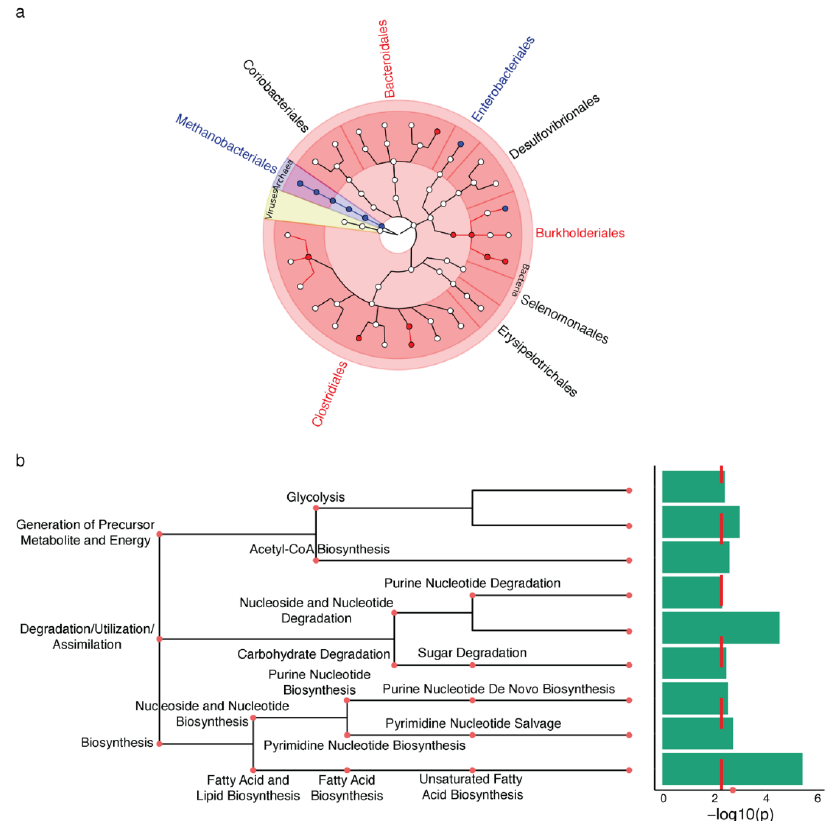
Figure 1. The Parkinson’s disease (PD) appendix exhibits shifts in the active microbiota that affect lipid metabolism. Meta- transcriptomic analysis was used to determine the changes in the functional microbiota in the PD appendix ( n = 12 PD, 16 controls). ( a ) Microbiota changes in the PD appendix. Metatranscriptome data were analyzed by MetaPhlAn2 and a zero- inflated Gaussian mixture model in metagenomeSeq, adjusting for age, sex, RNA integrity number (RIN), and post-mor- tem interval. Results are displayed using GraPhlAn, showing the taxonomic tree with the kingdom in the center, and branching outwards to phylum, class, order, family, and genus. Microbial taxa highlighted in red are increased in PD, and blue are decreased in PD ( q < 0.05, metagenomeSeq). ( b ) Microbiota metabolic processes are altered in the PD appendix. Top microbial pathways are altered in PD as identified by HumanN2. Red dashed line denotes q < 0.1 pathways as deter- mined by metagenomeSeq.